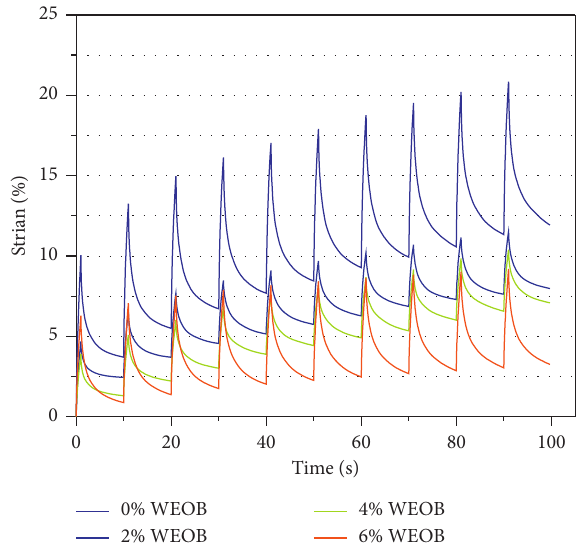
Figure 7: Strain response in MSCR test (10 cycles) for binders at 64 ° C and